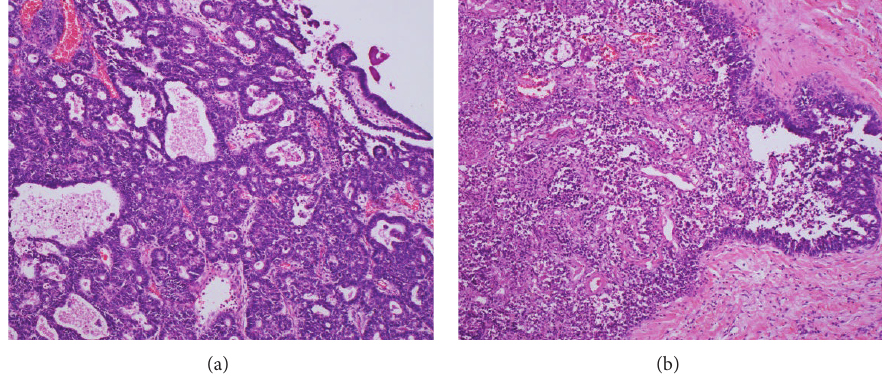
Figure 3: Pathological findings. (a) A grade 1 endometrioid adenocarcinoma is characterized by glandular patterns resembling those of the endometrium. (b) Extensive necrosis of the endometrioid carcinoma (left side). (a-b) Hematoxylin and eosin staining (magnification, ×